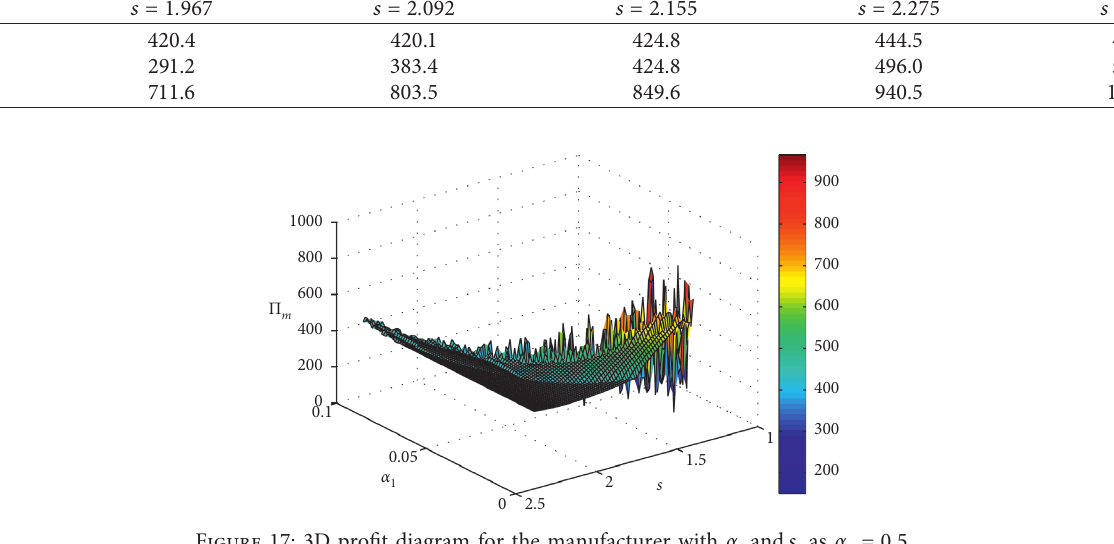
� 0 . 5. and s , as α 1 2